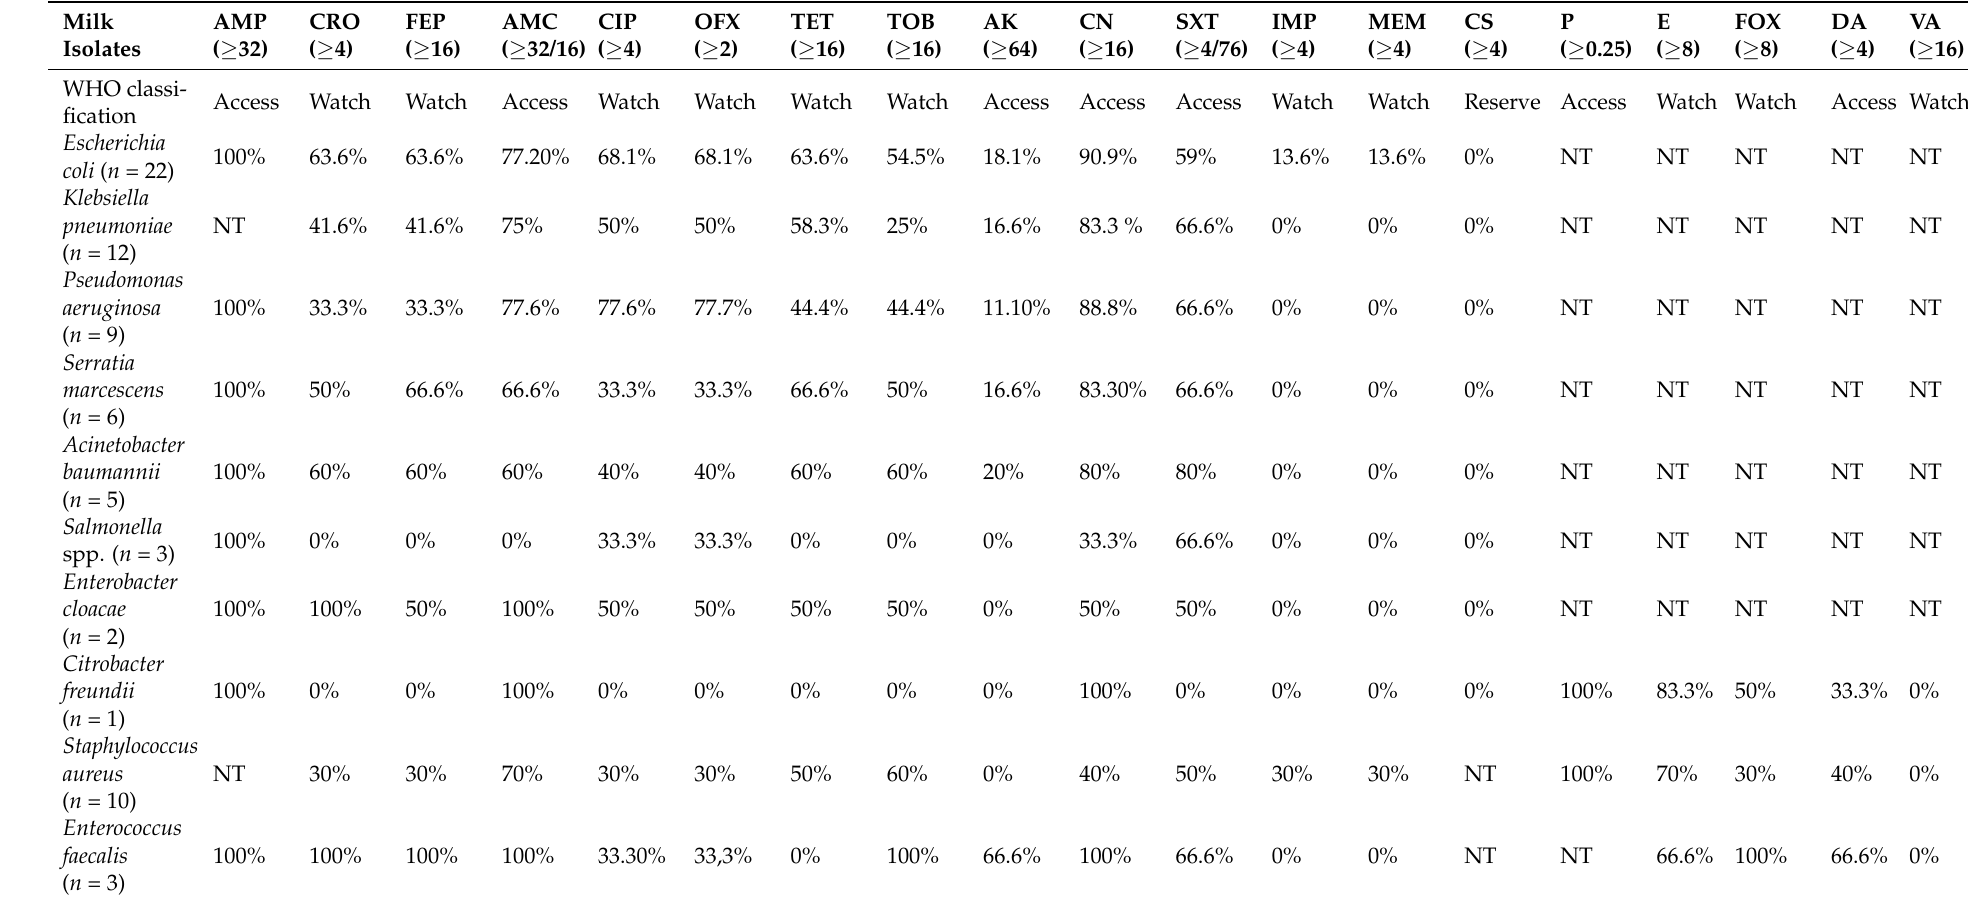
Table 4. Antimicrobial resistance profile (minimum inhibitory concentration [ µ g/mL]) of bacteria isolated from bovine milk